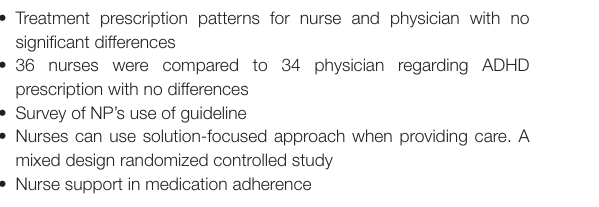
TABLE 2 | Review of studies evaluating nurse role.